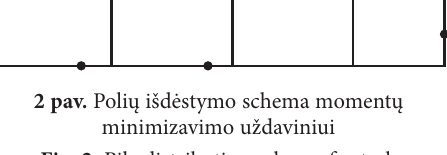
Fig. 3. Pile distribution scheme for task of reactive